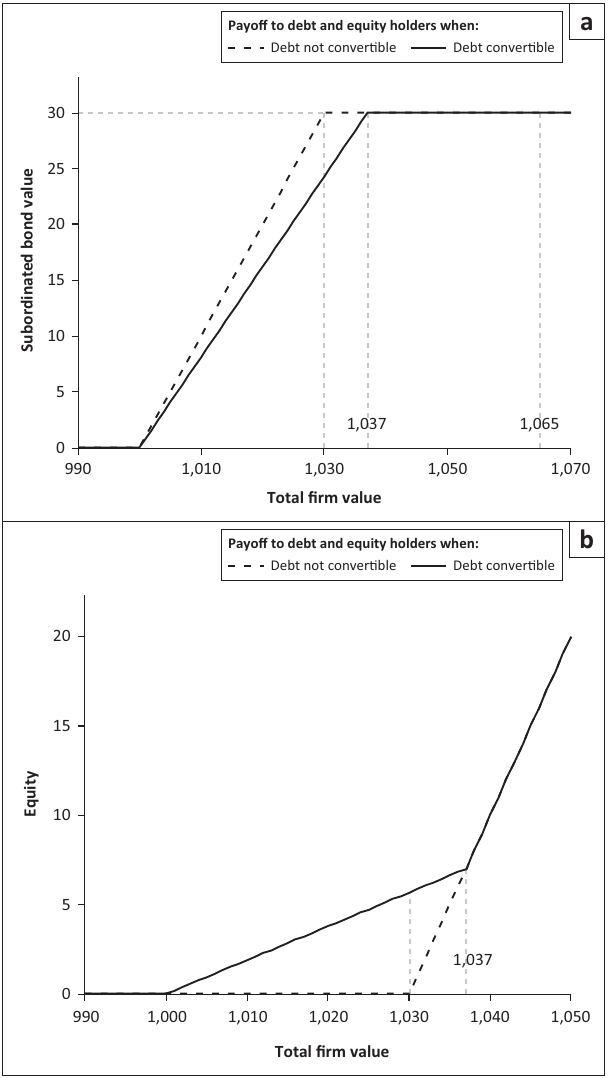
FIGURE 4: Comparison of Call Option Enhanced Reverse Convertible and straight debt payoff profiles: (a) subordinated bond value and (b) equity.